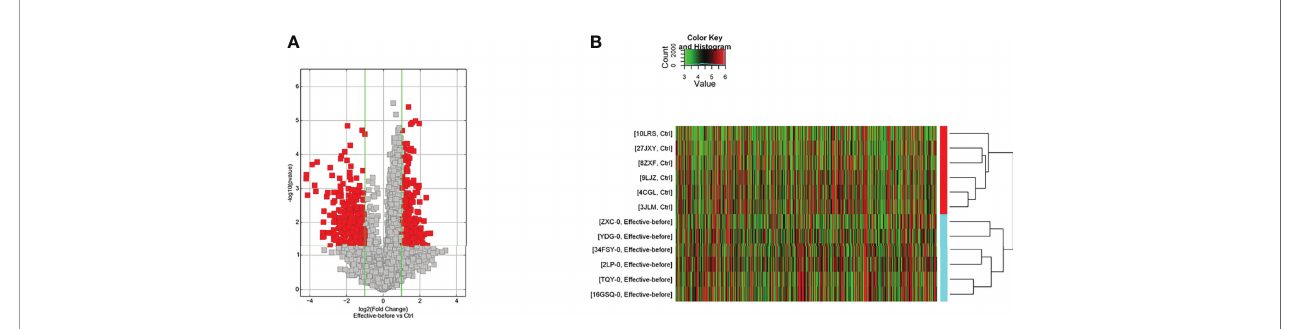
FIGURE 2 | Differentially expressed lncRNA in the disease group compared to the before treatment/healthy control group [ (A) Volcano map; (B) Clustering heat